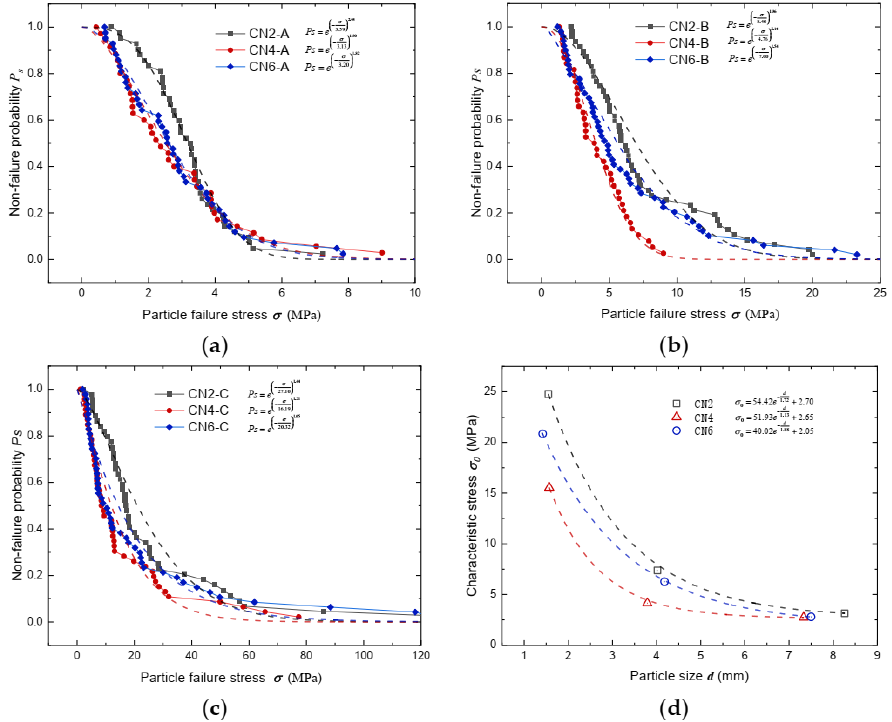
Figure 10. Effect of coordination number on particle non-failure probability distribution curves for ( a ) fraction 5–10 mm, ( b ) fraction 2–5 mm, and ( c ) fraction 1–2 mm; ( d ) characteristic stress against particle size plot for different coordination number testing